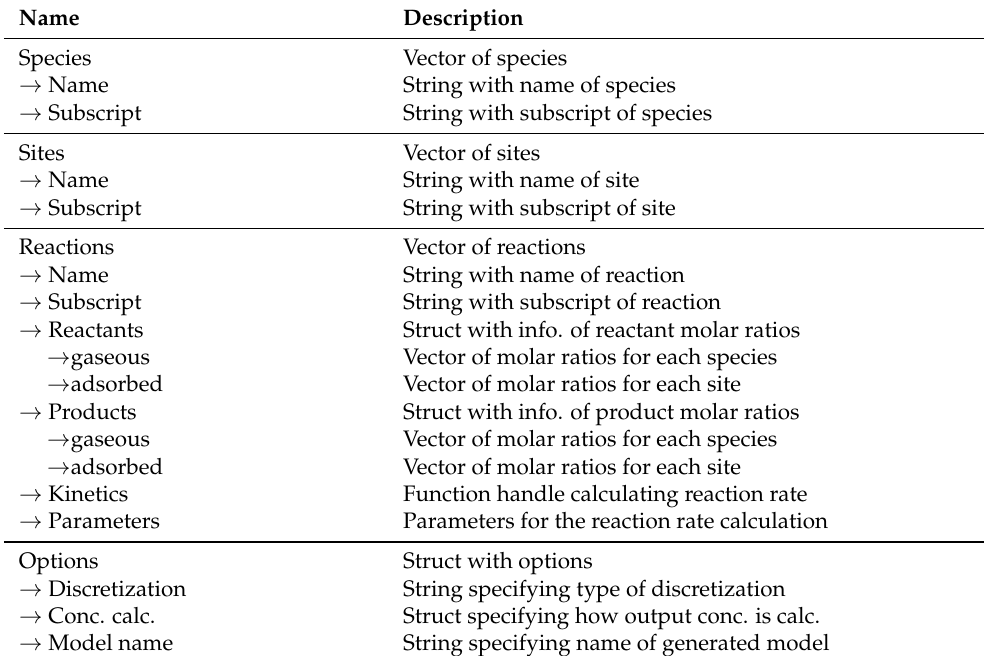
Table 1. Inputs for the model generation